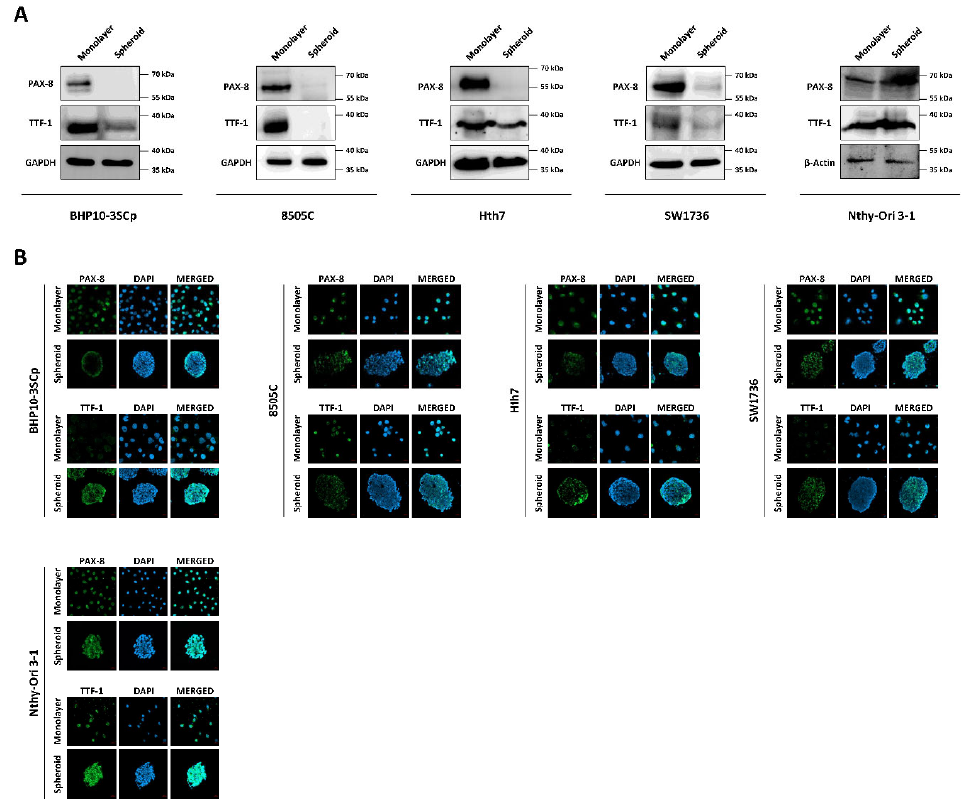
Figure 9. Monitoring of thyroid transcription factors (PAX ‐ 8, TTF ‐ 1) under the 2D monolayer and 3D spheroid conditions. ( A ) Western blot analysis showing paired box gene ‐ 8 (PAX ‐ 8) and thyroid transcription factor ‐ 1 (TTF ‐ 1) expression. GAPDH and β‐ Actin were used as loading control. ( B ) Representative immunofluorescence images showing PAX ‐ 8 and TTF ‐ 1. Scale bar: 50 μ m.